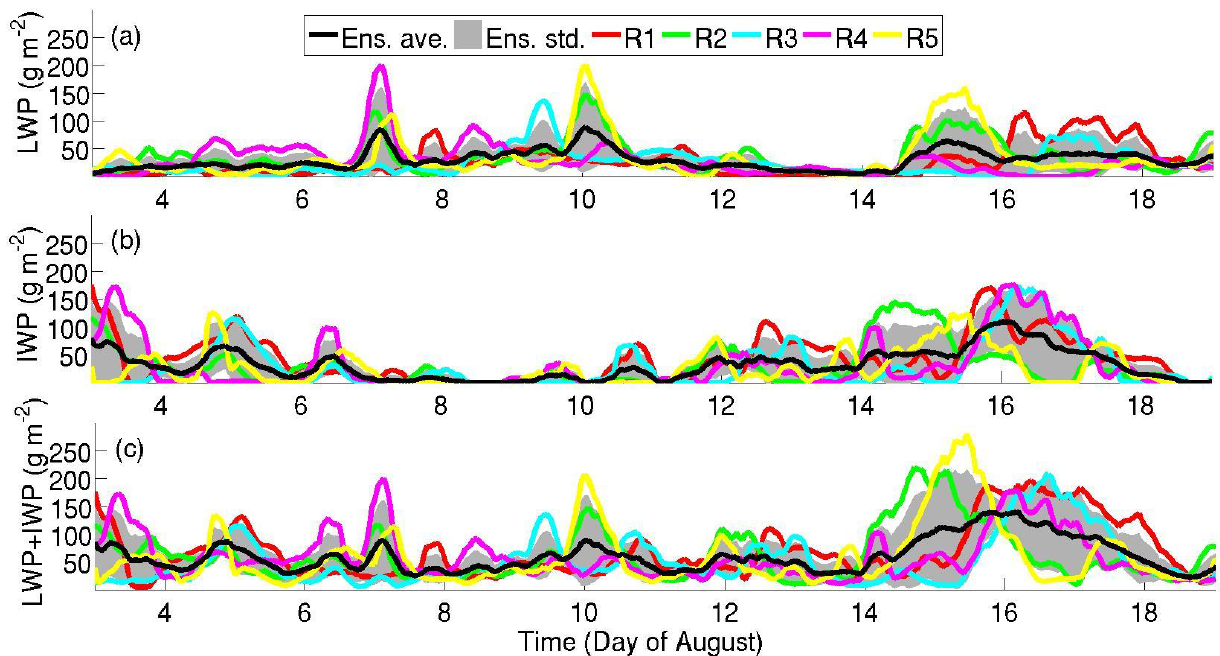
Figure 10. Time series of ( a ) LWP, ( b ) IWP and ( c ) total cloud water path in gm −2 for the ensemble average and for the different ensemble members. Ensemble spread (± one standard deviation) is indicated by the gray-shaded areas.